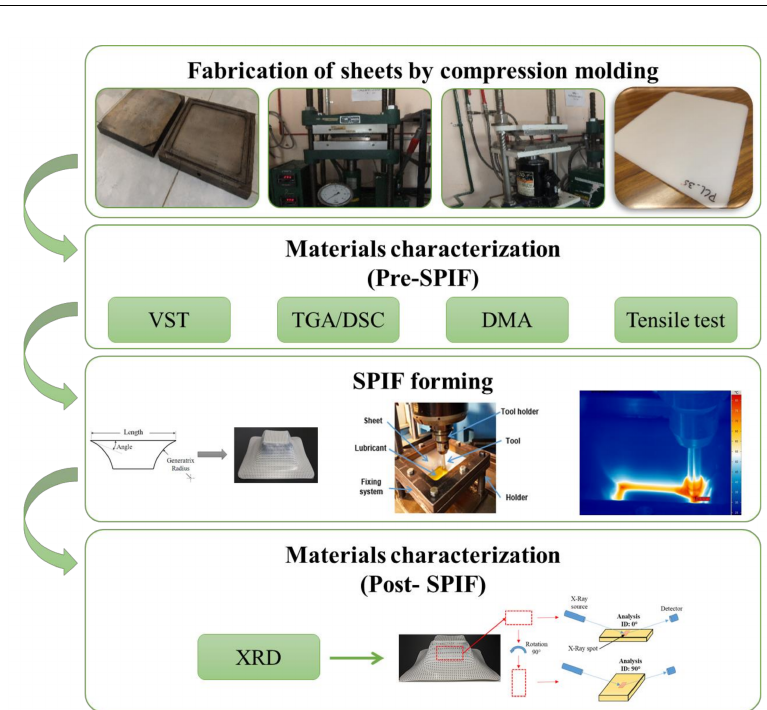
Figure 2. Summary of the experimental